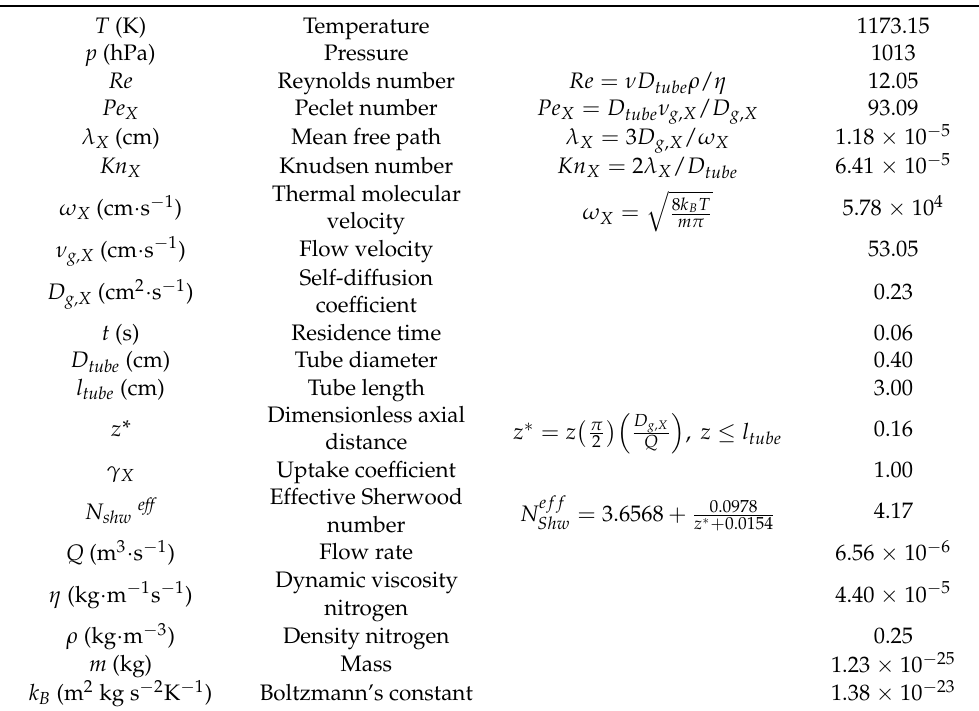
Table 1. A summary of the parameters applied in diffusion calculations for KCl in a nitrogen carrier gas at 900 ◦ C. See [36] for a definition of the individual parameters. T